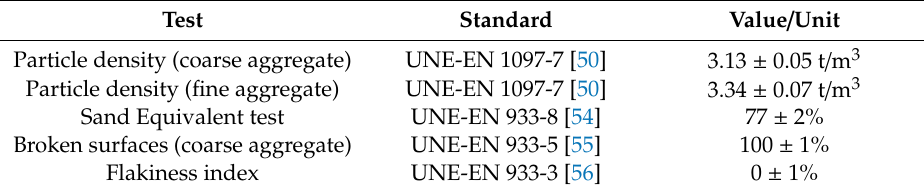
Table 9. Density and plasticity tests for the fine portion of ladle furnace